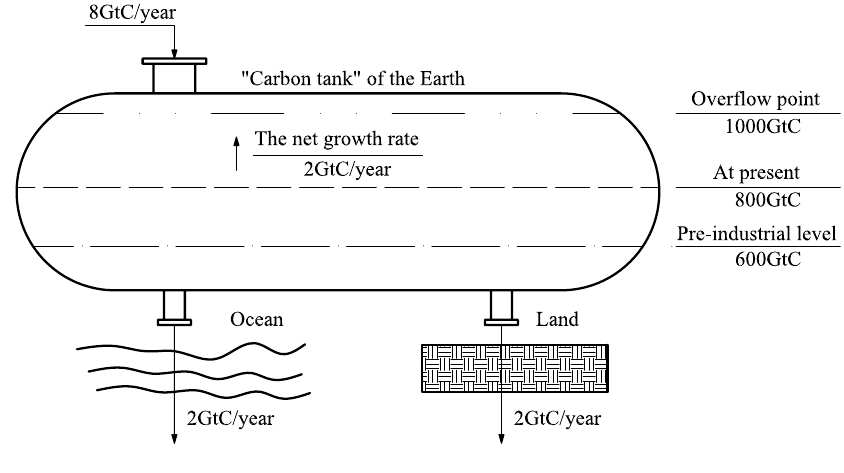
Figure 1. The atmosphere as a “carbon